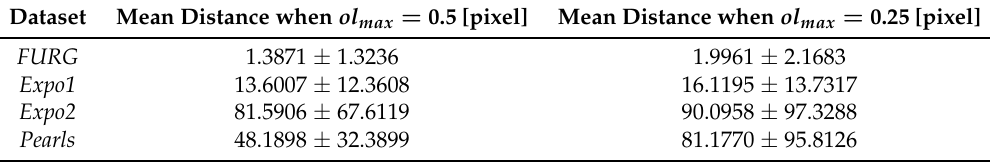
Table 5. Mean distance between corresponding nodes with respect to graph obtained with ol max = 1.0.